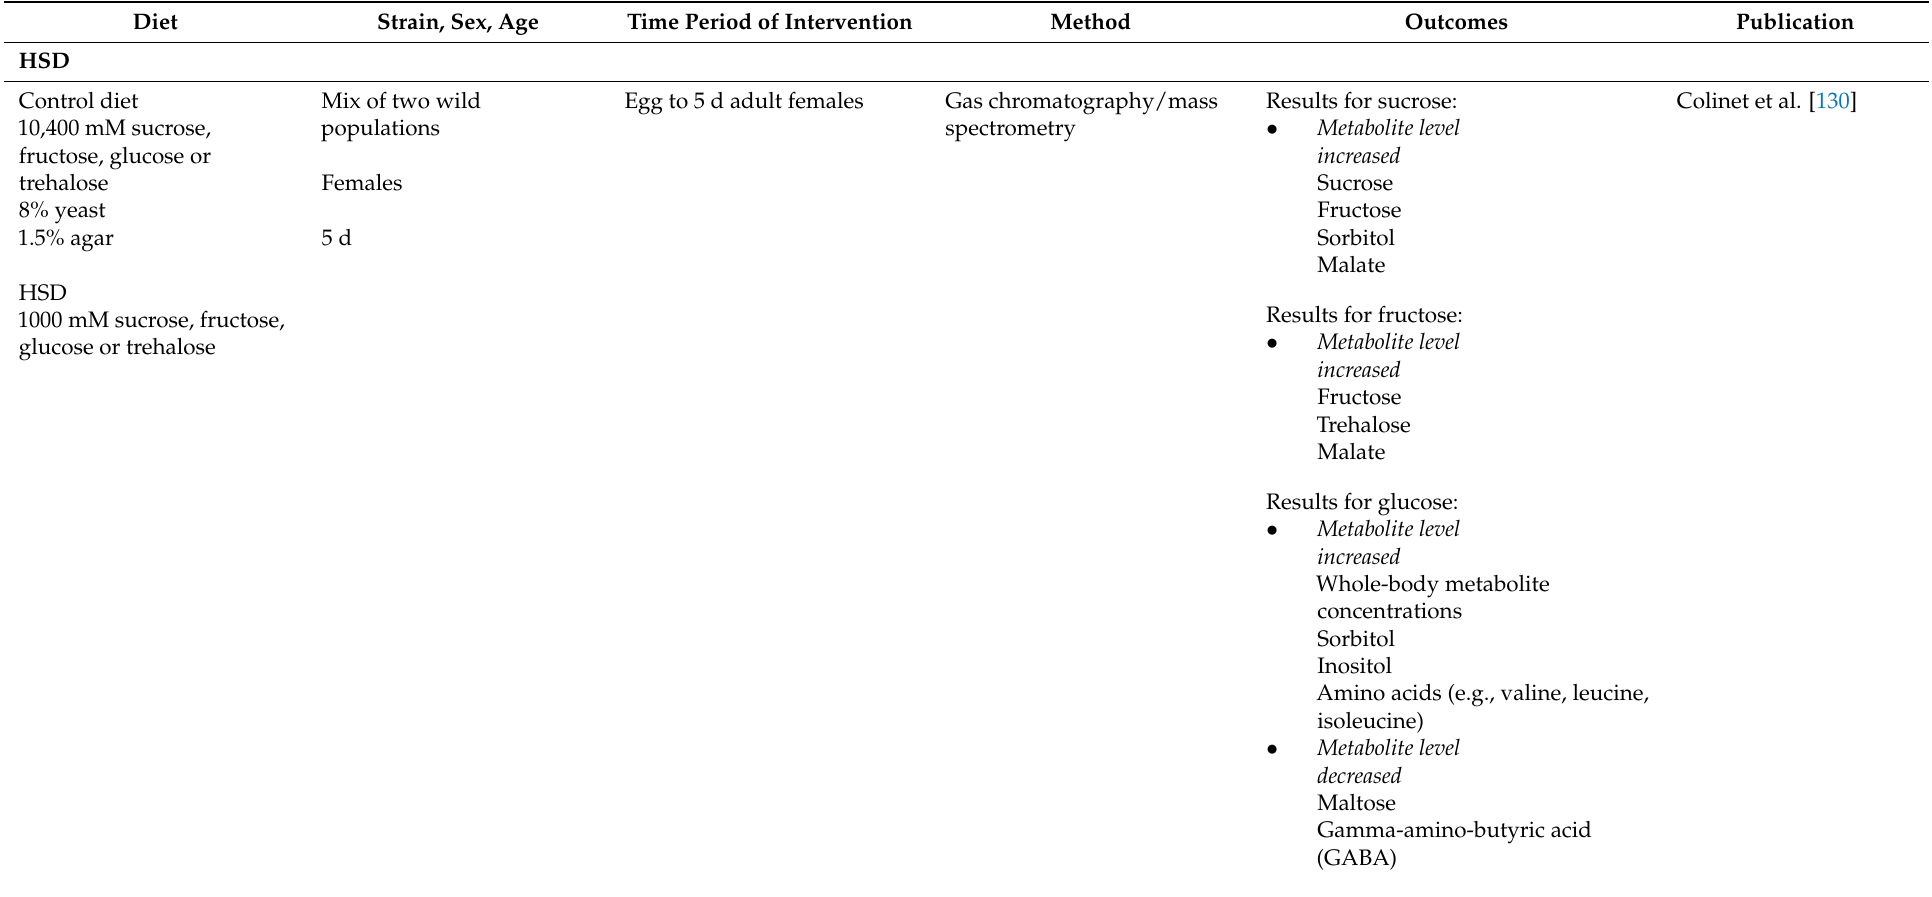
Table 5. Overview of dietary intervention studies regarding changes in metabolome following high-sugar diet (HSD) or high-fat diet (HFD) feeding in Drosophila melanogaster. The studies are ordered by release